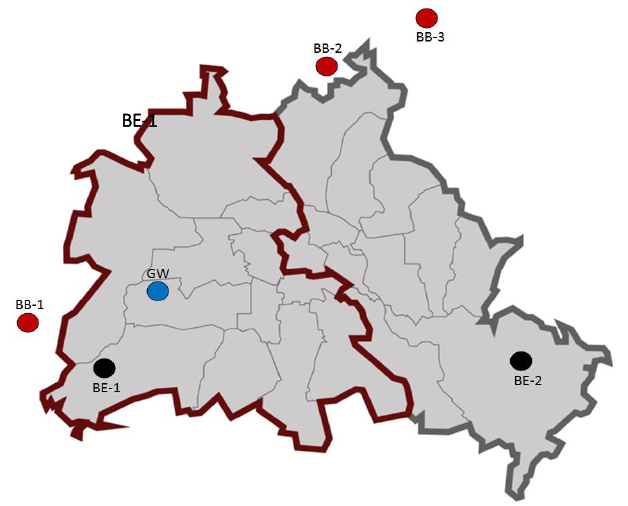
Figure 1. Origin and genetic characterization (Bayesian Analysis of Population Structure, BAPS cluster) of the wild boars tested. The locations are: Berlin Grunewald (GW, blue) (BAPS cluster 1), Berlin Brandenburg (BB-1, -2, -3; red), Berlin East (BE-1, -2, black) (all BAPS cluster 2). The red line indicates the Berlin wall around Berlin West, the gray line indicates the border of East Berlin. Outside Berlin is the state Brandenburg.